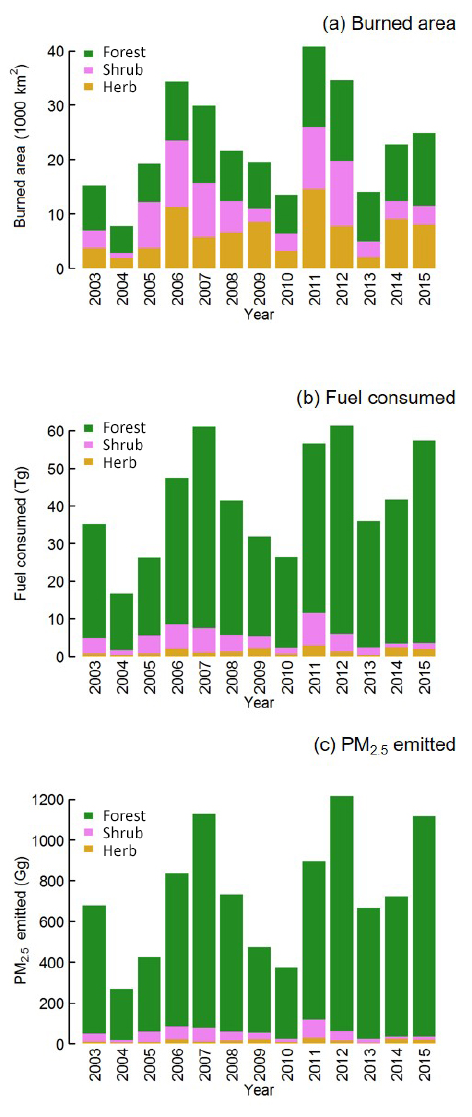
Figure 10. Annual burned area, fuel consumed, and PM 2 . 5 emitted for 2003–2015.